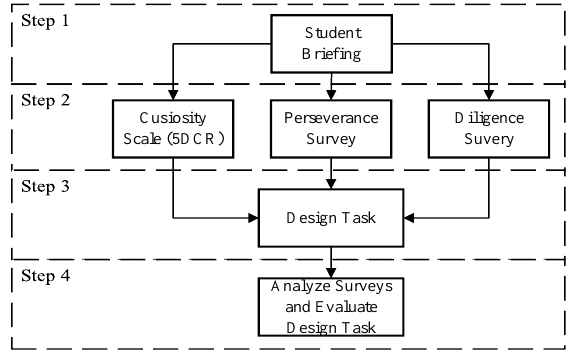
Fig. 1: Experimental approach